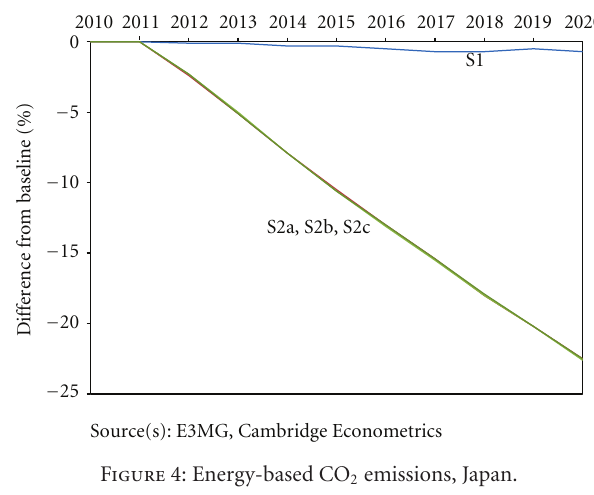
Figure 4: Energy-based CO 2 emissions, Japan.